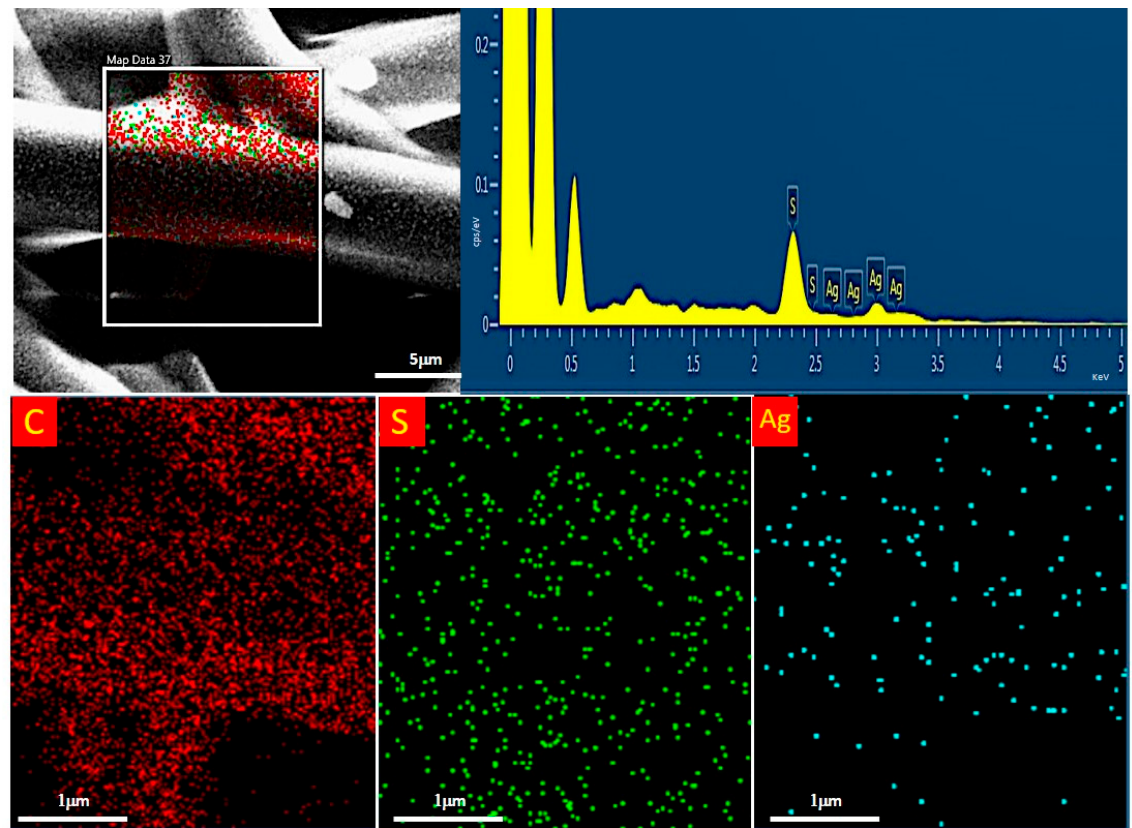
Figure 7. EDS analysis of the Ag-coated PSU fibers.